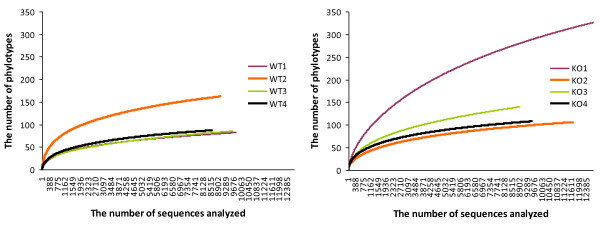
Rarefaction analysis performed by the RDP pipeline. Repeated samples of phylotype subsets were used to evaluate whether further sampling would likely identify additional taxa.